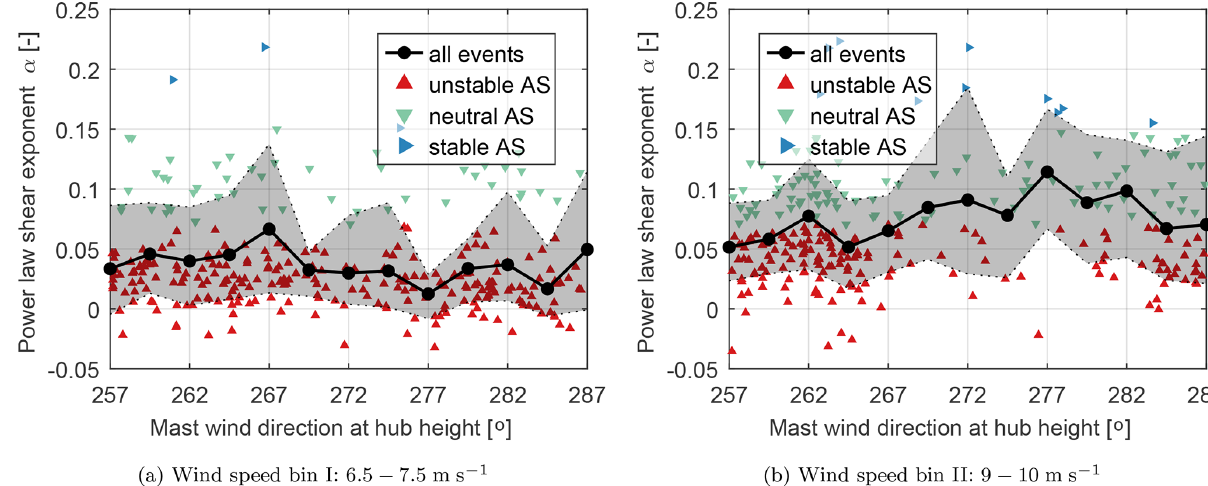
Figure 5. Power law shear exponent α derived from FINO1 measurements. Statistics are shown as mean values per wind bin. The shaded area indicates the 15th and 85th percentiles. Scatter shows α of single 10min events. AS = atmospheric